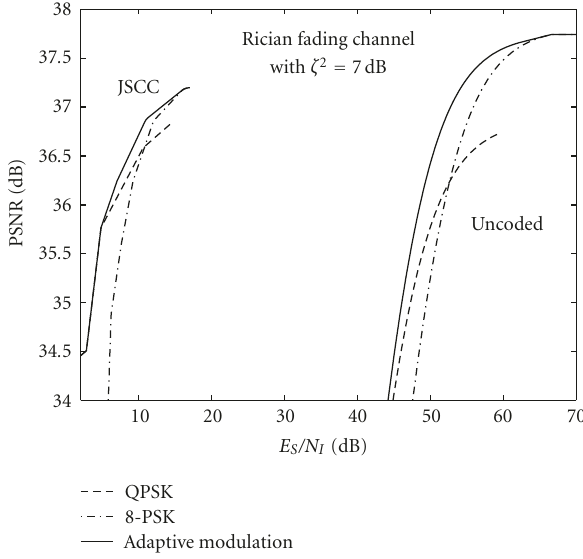
Figure 12: PSNR as a function of E S /N I in dB for 2-layer adaptive modulation and coding scheme for Rician fading channel with ζ 2 = 7dB. Fixed symbol transmission rate r S = 128